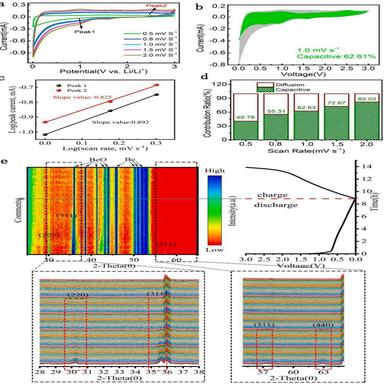
(a) CV curves from 0.5 to 2.0 mV s − 1 ; (b) separation of capacitive and diffusion currents at 1.0 mV s − 1 ; (c) the relationship between peak current and scan rate; (d) contribution ratios of the capacitive and diffusion-controlled charge; (e) In situ XRD results of (FeCoNiCrMn)3O4 HEO in the first cycle.